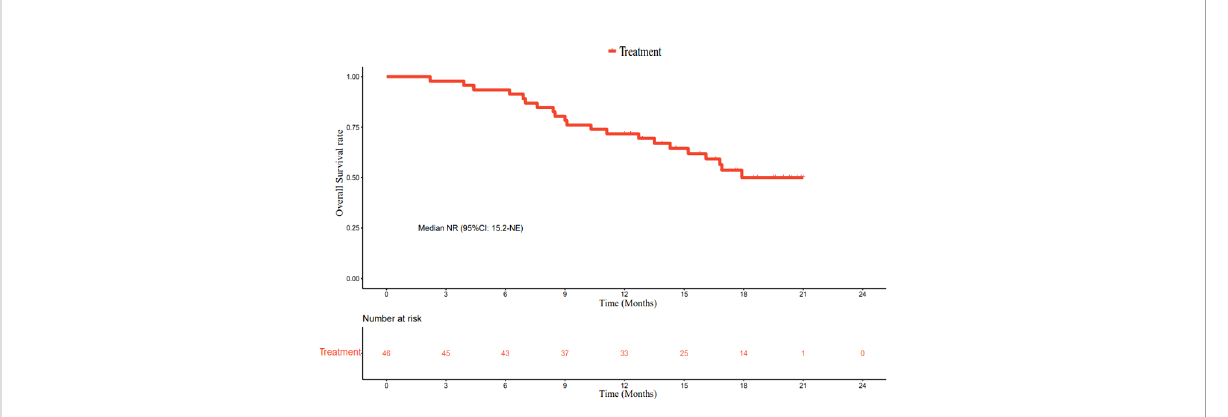
FIGURE 5 Kaplan – Meier plot of overall